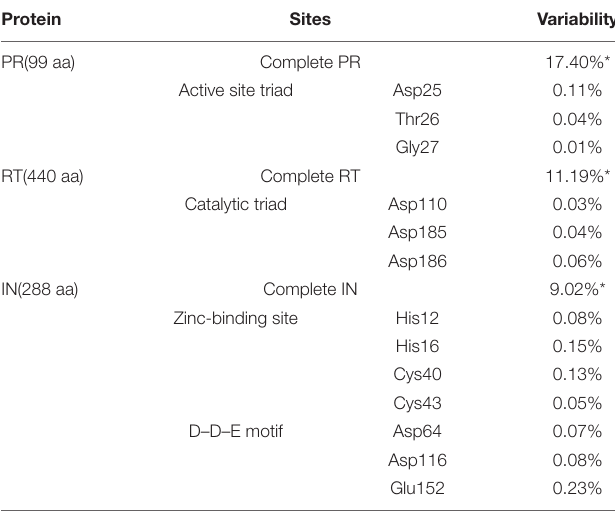
TABLE 1 | Variability in protease (PR), retrotranscriptase (RT), and integrase (IN) active sites. Protein Sites